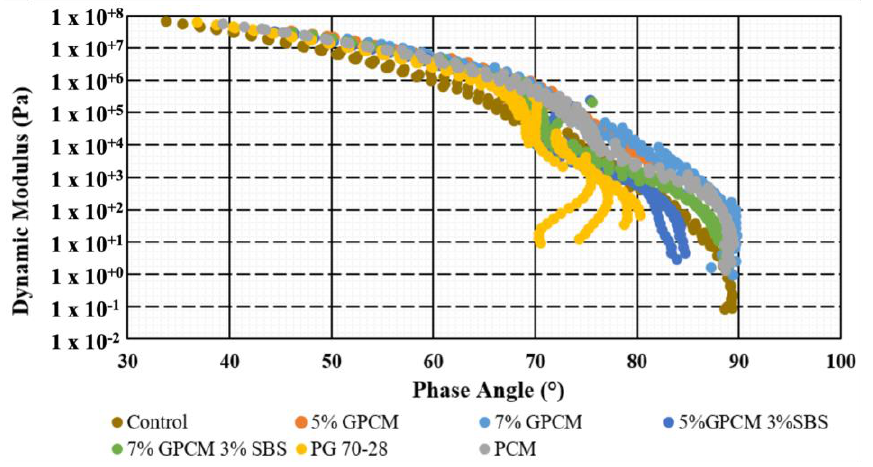
Figure 14. Black Space curves for all binders .